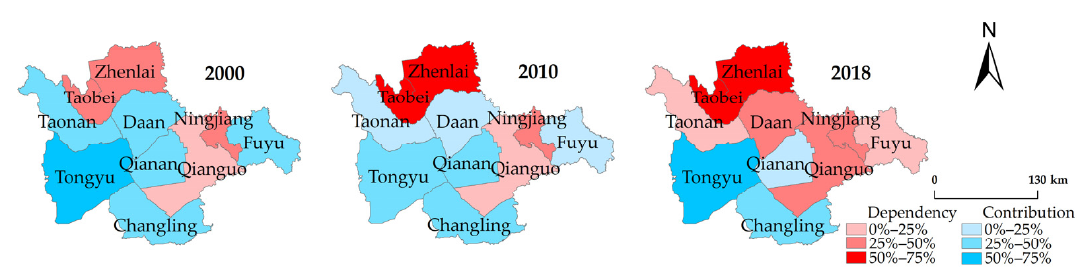
Figure 4. Spatial variation map of the supply/demand ratio of water resources in western Jilin at the county scale.